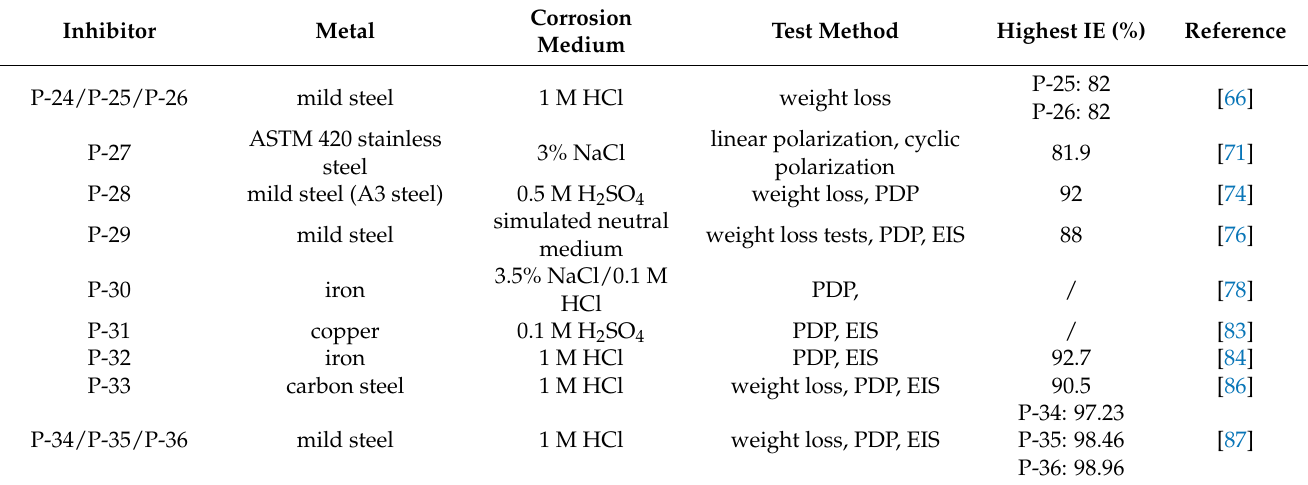
Figure 11. Typical chemical structure of polyaniline-based inhibitors. Table 4. Inhibition property of typical nitrogen-containing synthetic polymeric